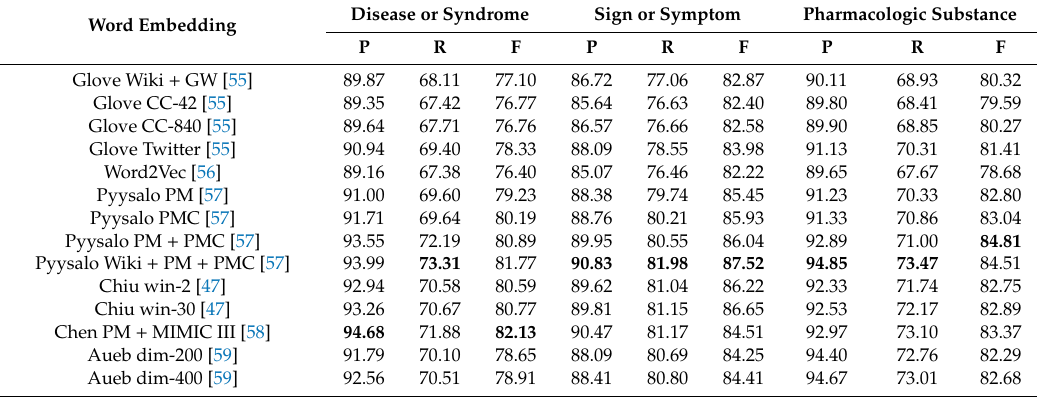
Note: The best results are highlighted in